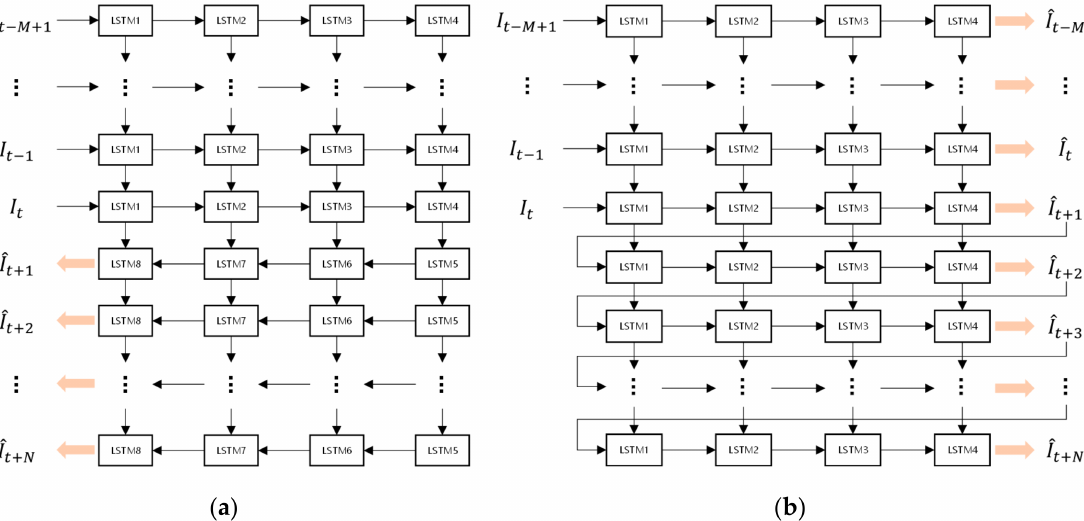
Figure A1. Two commonly used Seq2Seq structures for RNN-based radar echo extrapolation (choos- ing ConvLSTM as the basic unit). ( a ) The “same-side” structure; ( b ) The “opposite-side”